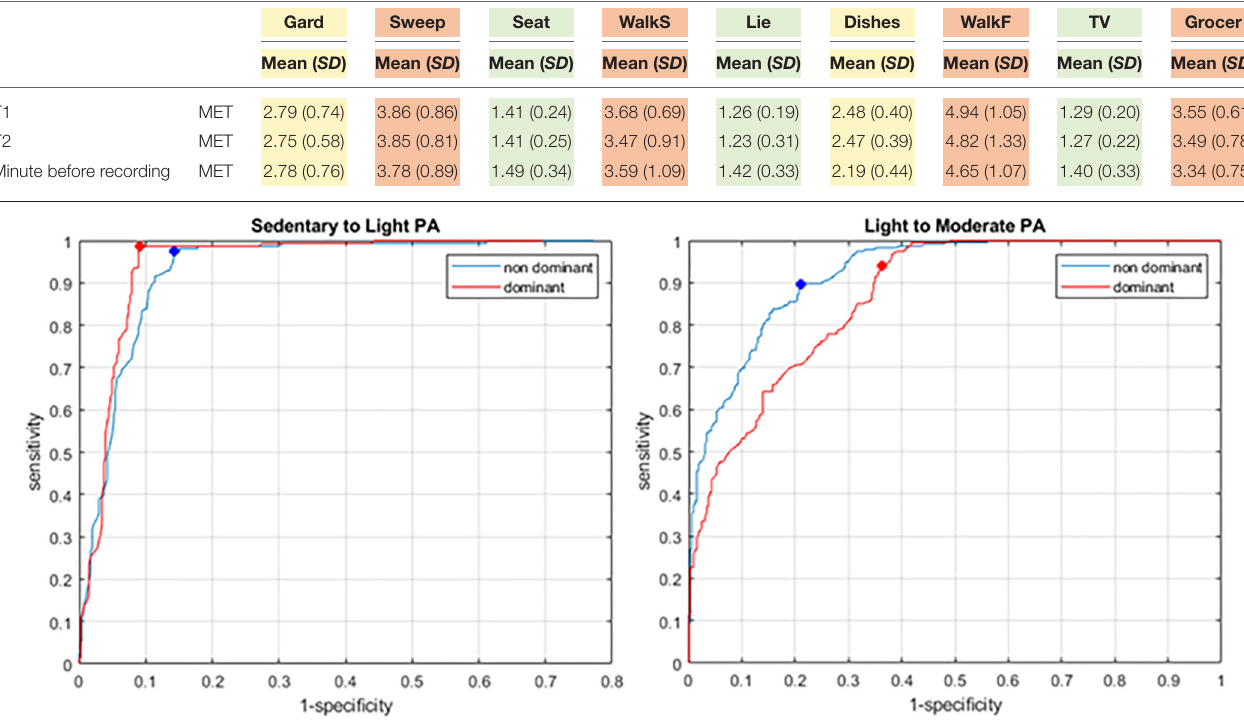
FIGURE 2 | ROC for the sedentary to LPA (left) and LPA to MPA (right) cut points. Dominant and non-dominant wrists are shown in red and blue, respectively. The dots show the selected cut-points maximizing the product of sensitivity and 1-specificity.